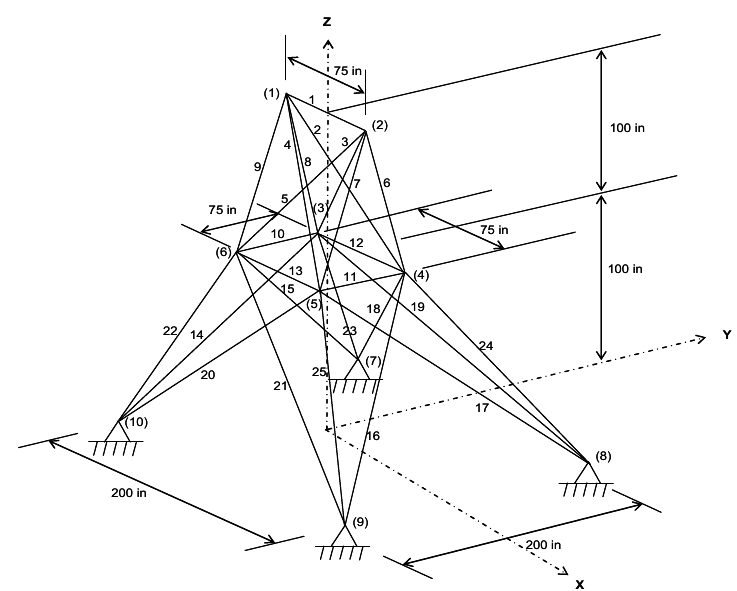
Figure 4. Schematic of the spatial 25-bar truss structure. Table 3. Stress limits for the 25-bar truss problem.